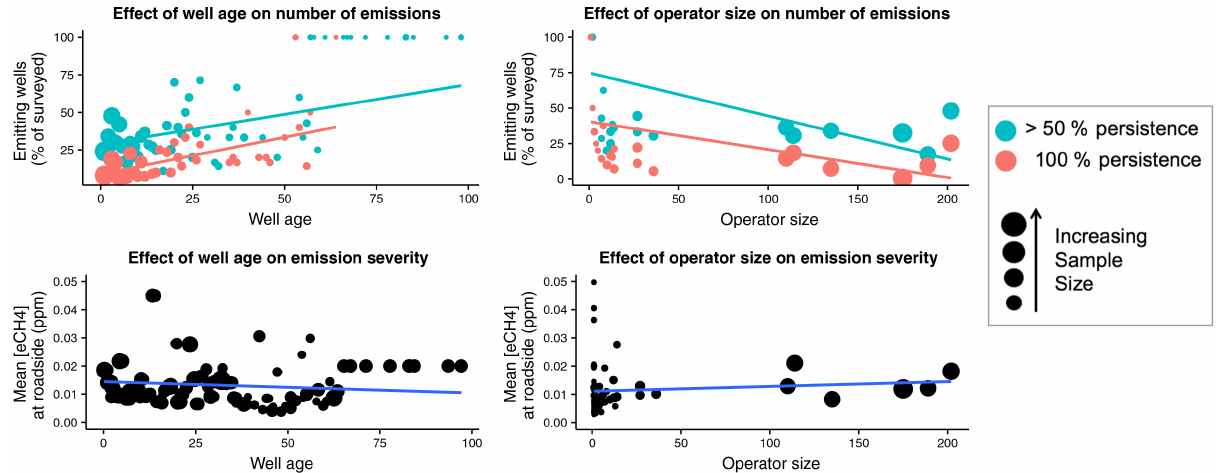
Figure 10. Effect of infrastructure age and operator size on detected emissions. The sizes of the dots represent the number of samples taken. Red dots are those recorded at the 100% persistence level, while green dots are at 50%